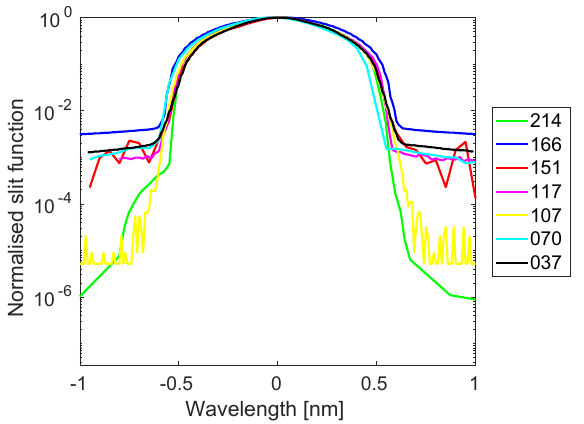
Figure 1. Slit functions of Brewers no. 037, 070, 107, 117, 151, 166 and 214. The results are normalised to the maximum and the x axis is wavelength (nm) relative to the peak